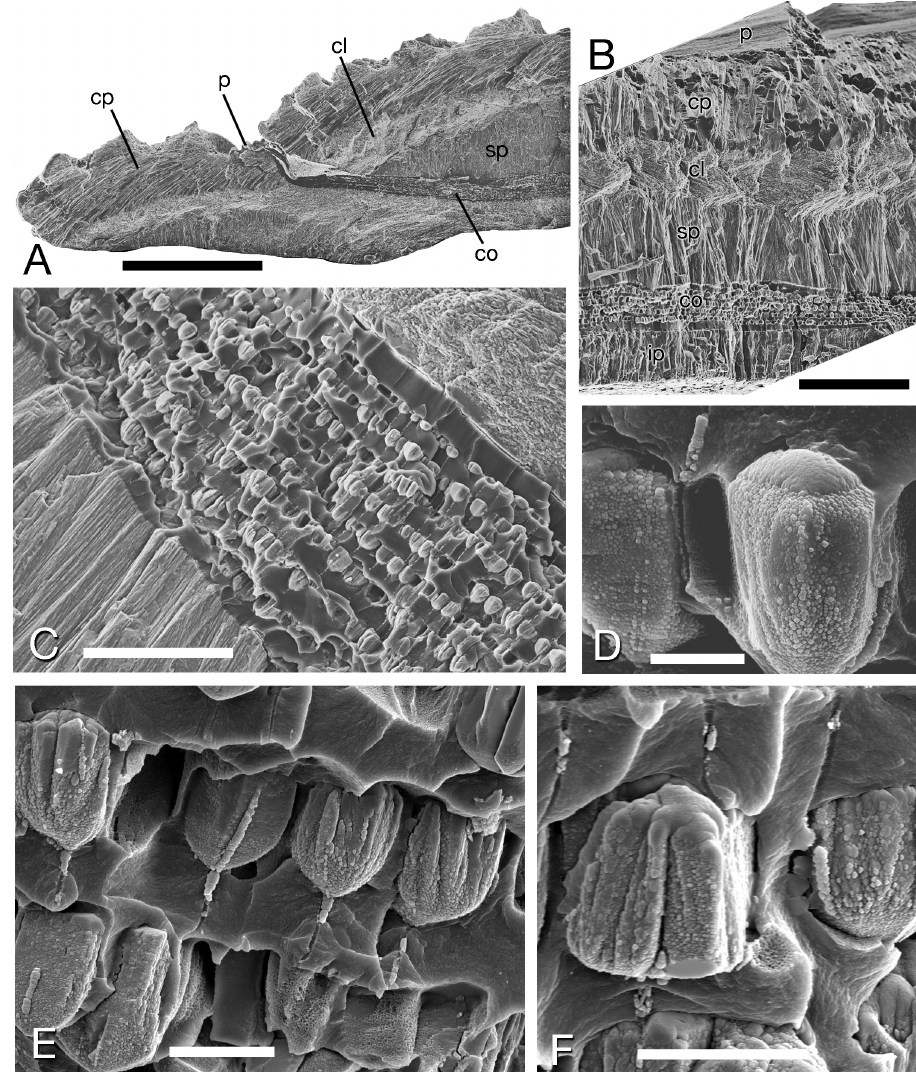
Figure 4. Shell microstructure of Pleurolucina harperae . A Fractured section of shell margin showing major notch growth halt and conchiolin layer. Scale bar = 400 µm B Fractured section showing succes- sion of shell layers. Shell exterior at top. Scale bar = 100 µm C Conchiolin layer with regular bands of spherulites. Scale bar = 40 µm D Individual spherulite. Scale bar = 2 µm E Adjacent spherulites embedded in conchiolin with narrow channels between layers. Scale bar = 5 µm F Single spherulites with channels below and above. Scale bar = 5 µm. cl crossed lamellar layer co conchiolin layer cp composite prismatic layer ip irregular prismatic layer p periostracum sp spherulitic prismatic